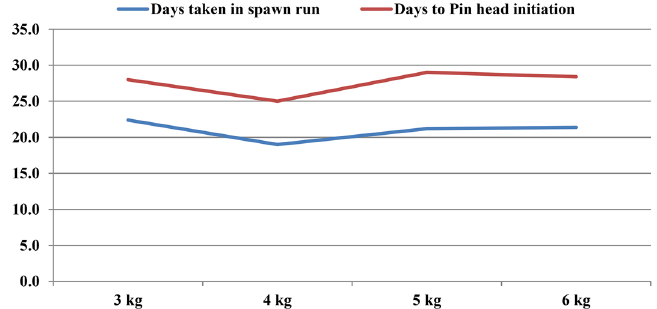
Figure 10. Average days taken in spawn run completion and days taken to pin head initiation on different substrate quantities.